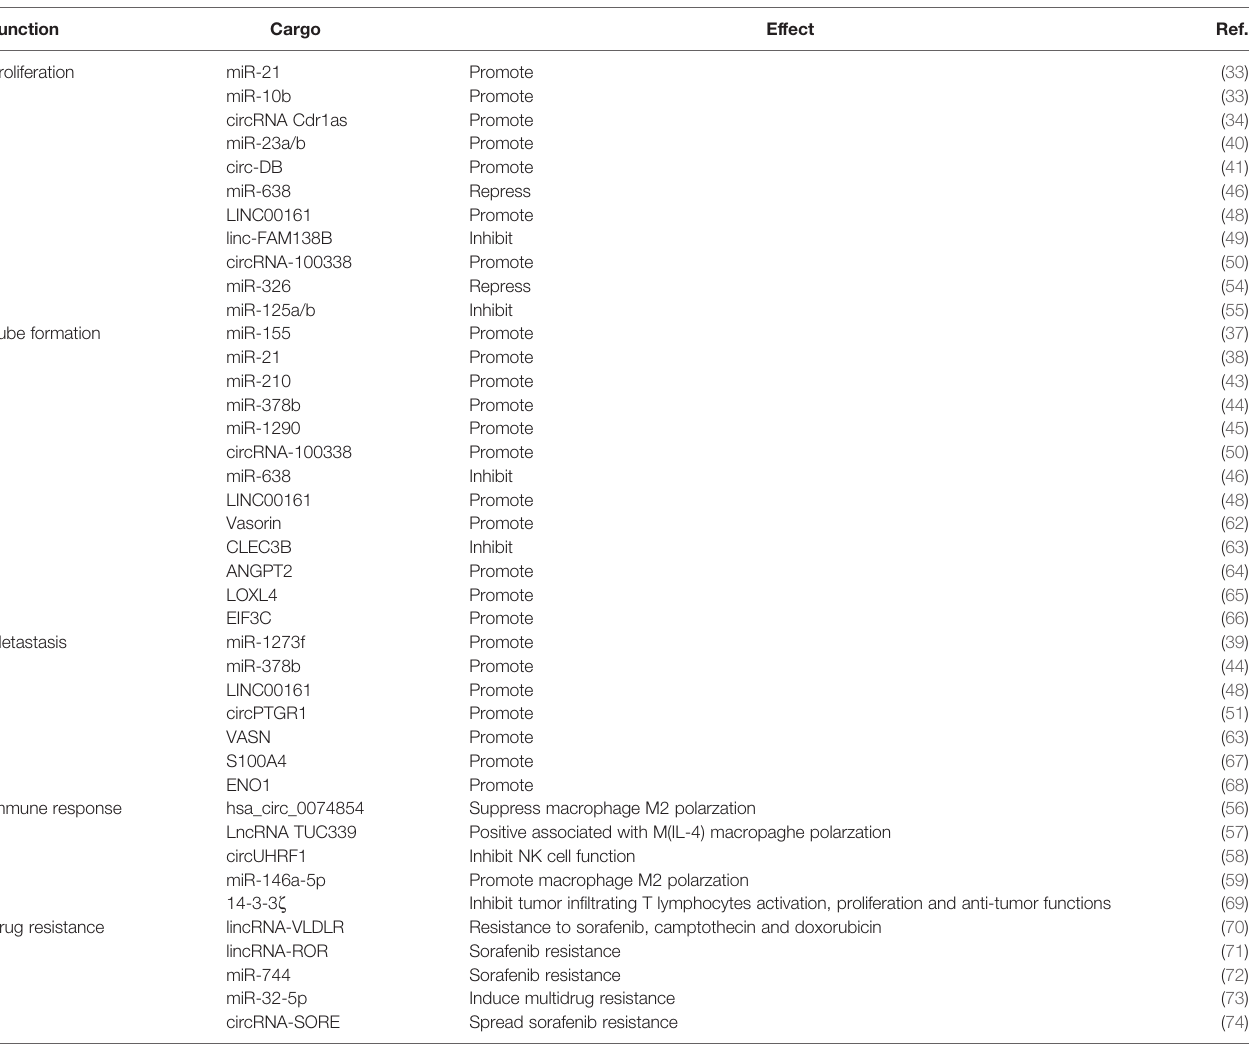
TABLE 1 | Primary functions of non-coding RNAs and proteins in exosomes from HCC.